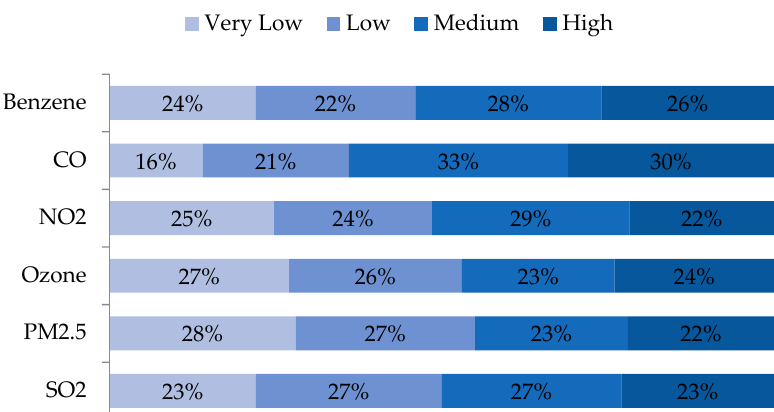
Figure 9. Distribution of exposure category based on WA metrics, for all observations with ambient air measurements indicating ‘Medium’ exposure, by pollutant.